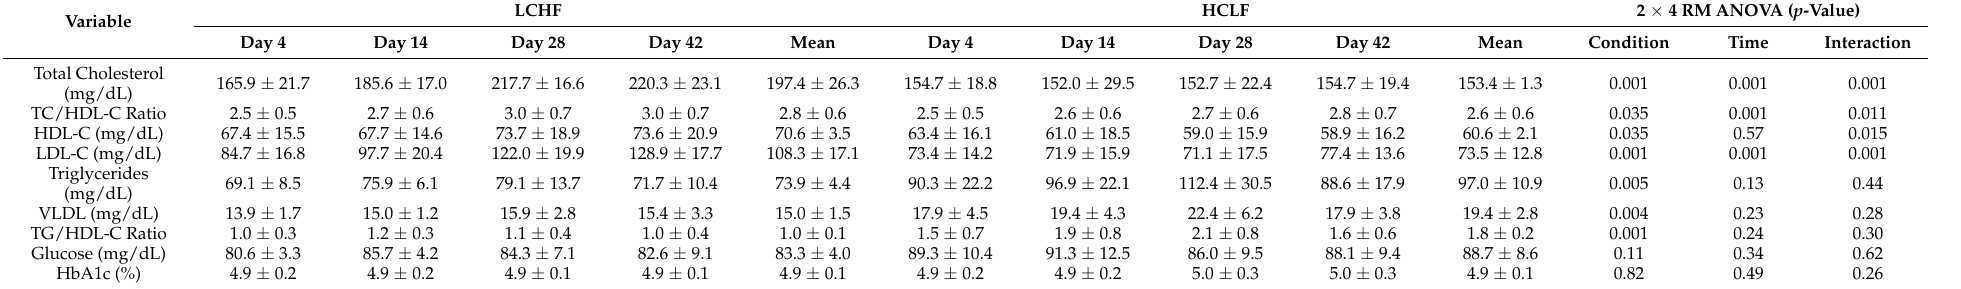
Table 3. Changes in Plasma Lipids and Lipoproteins at Day 4, 14, 28, and 42 for LCHF and